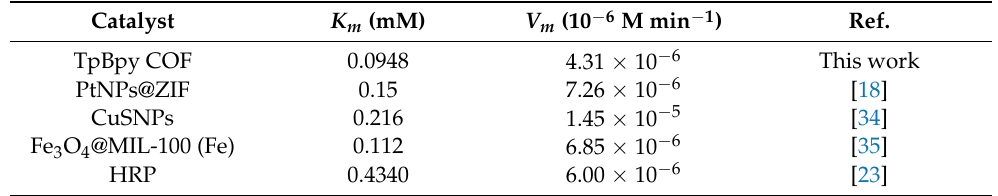
Figure 3. ( A ) UV-vis spectra of different chromogenic substrates with/without TpBpy COF in the HAc-NaAc buffer (0.2 mol L − 1 , pH 4.0). Insert: the images of the system containing TMB (a, a’), APTS (b, b’), and OPD (c, c’). ( B ) Density functional theory (DFT) calculation of TpBpy COF (Insert: the images of LUMO and HOMO). ( C ) EPR spectra of TpBpy COF after illumination under white-light LED lamp for 20 min and under dark environment. ( D ) Michaelis–Menten and Lineweaver–Burk curves of TpBpy COF against the different concentrations of TMB. Table 2. The kinetic parameters of oxidation reactions catalyzed by reported enzyme-like nanomate- rials and horseradish